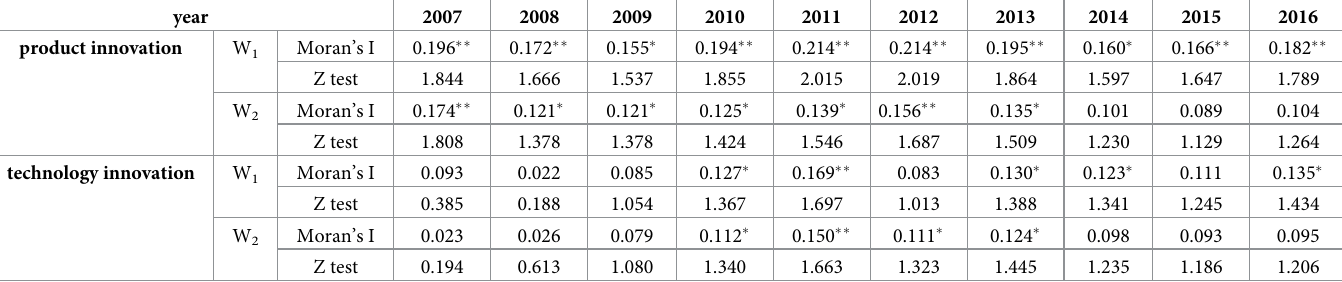
Table 2. Global Moran’s I of